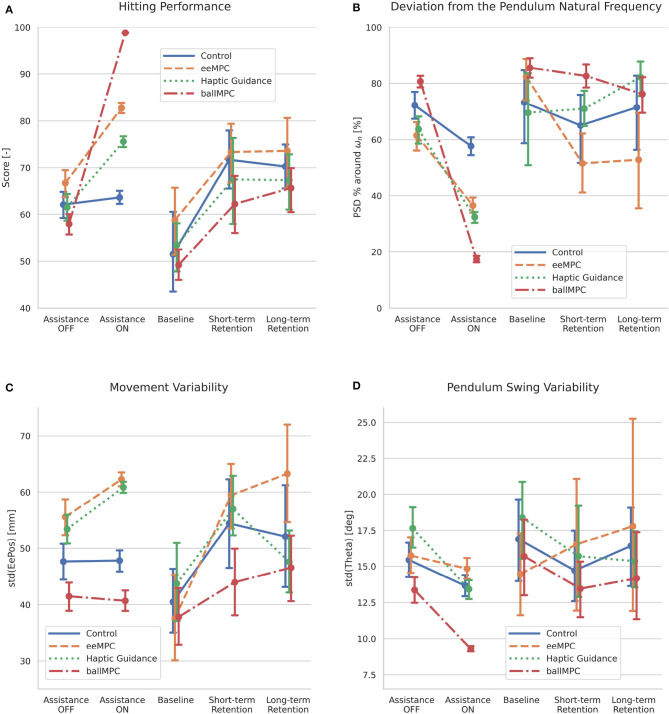
Effect of the training strategies on participants' performance during training (assisting forces ON and OFF) and baseline and retention tests. (A) Hitting performance (score). (B) Deviation from pendulum natural frequency (PSD % around
wn). (C) Movement variability [std(EePos)]. (D) Pendulum swing variability [std(Theta)]. Error bars indicate the 95% confidence interval.